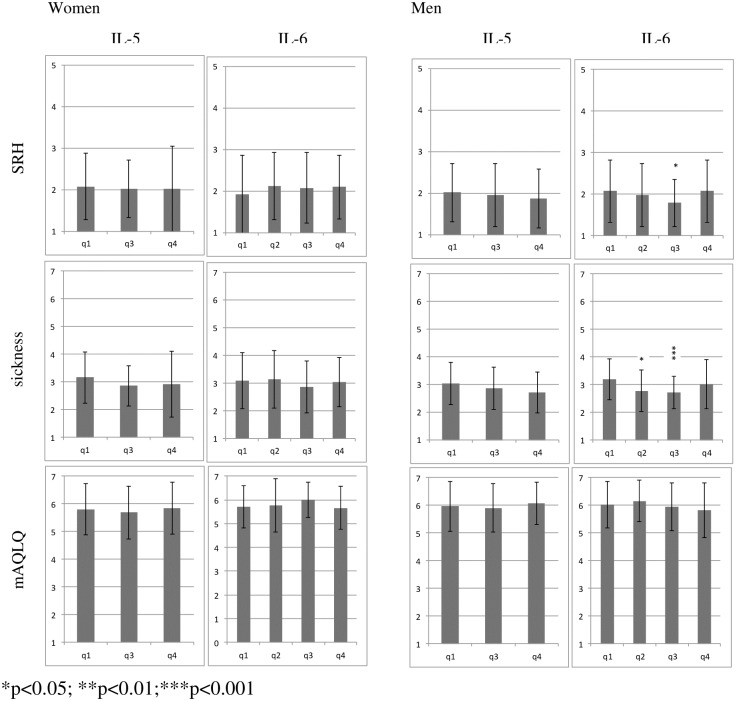
Distribution of self-rated health, sickness behaviour and asthma-related quality of life per cytokine-quartiles.Higher scores on the y-axis denote worse self-rated health, more pronounced sickness behaviour and better asthma-related quality of life. Error bars are used for standard deviation. For IL-5, quartile one and two were collapsed to one reference category due to a substantial proportion of IL-5 falling below the limit of detection. Abbreviations: SRH—self-rated health, IL—interleukin, mAQLQ—mini asthma-related quality of life questionnaire, q—quartile.